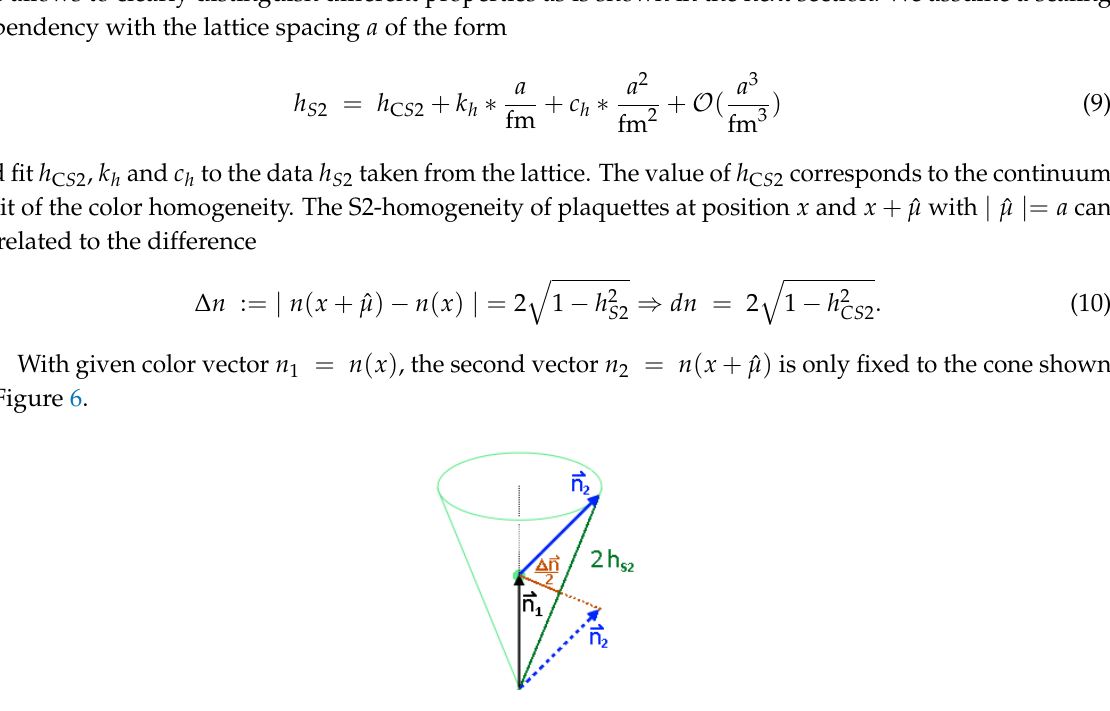
Figure 6. By Equation (10) the S2-homogeneity h S 2 of two color vectors n 1 and n 2 is related to the norm ∆ n = . n 2 n 1 | − |